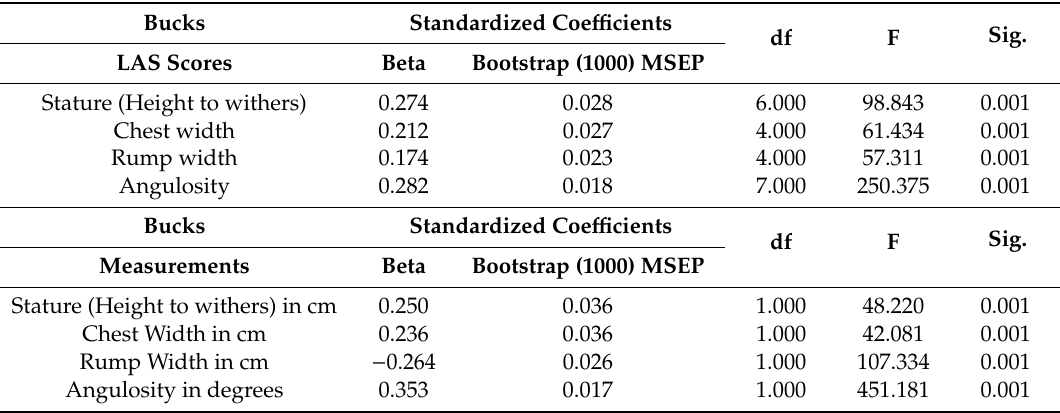
Table 6. β -standardized coe ffi cients to replace the Z score in each of the respective equations in Supplementary Table S5 and a 0.632 bootstrap mean squared error of prediction (MSEP) for the comparison of model validity between the two linear regression models using linear appraisal traits as opposed to Murciano-Granadina zoometric traditional assessment in bucks.